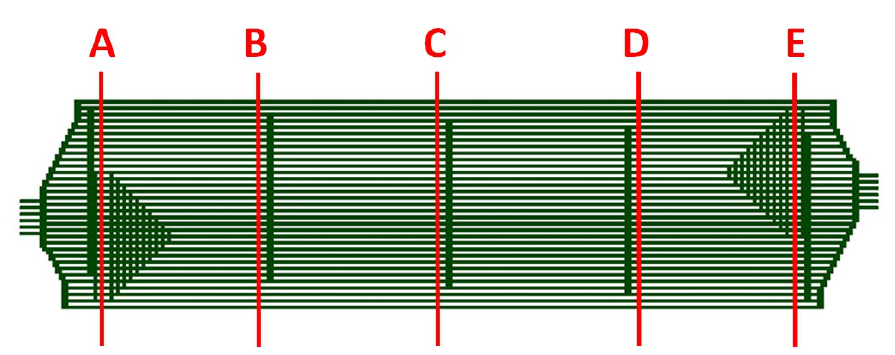
Figure 18. Selected positions for the calculation of the mass